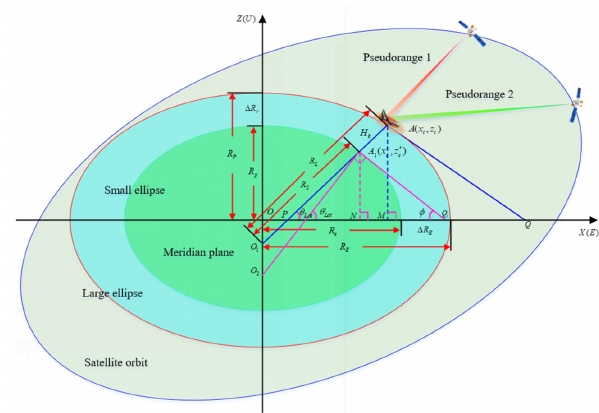
Figure 1. 2-dimensional schematic diagram of similar